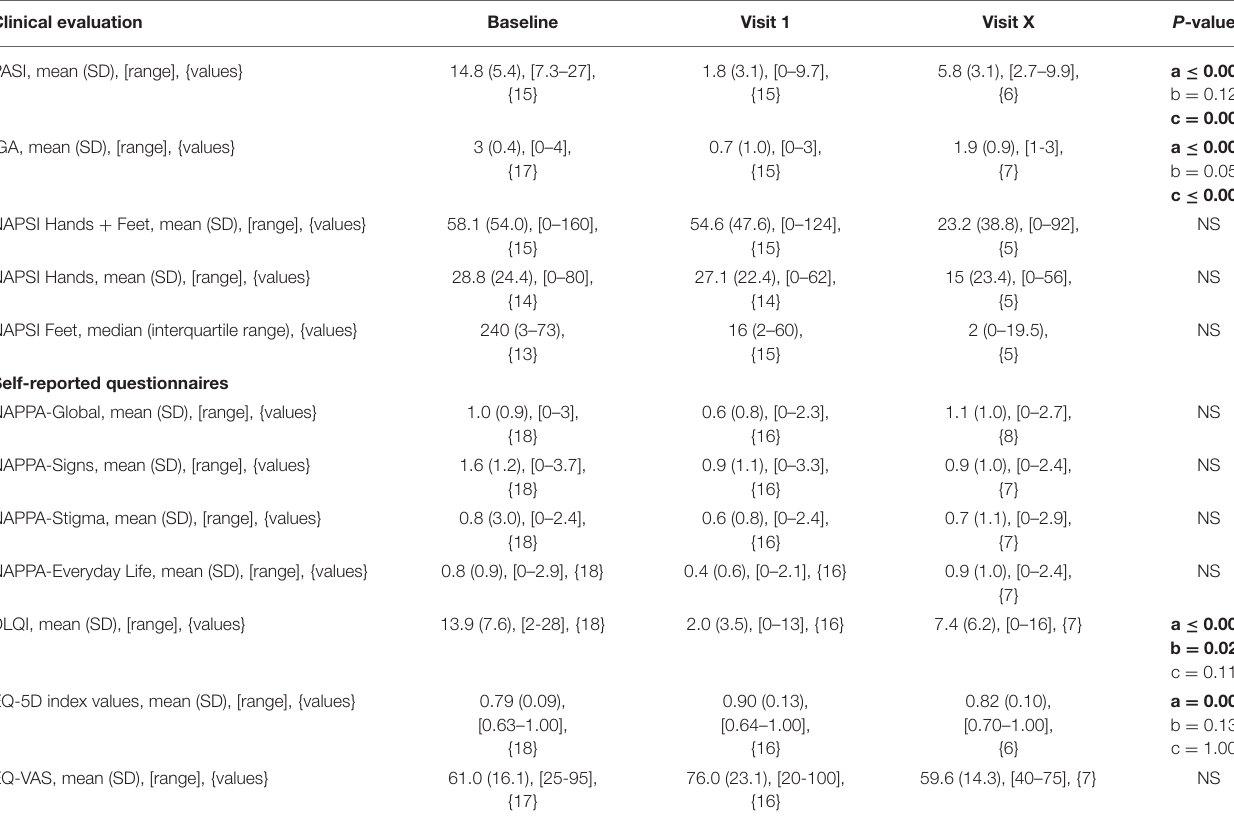
TABLE 2 | Results from clinical and patient questionnaire scores. Clinical evaluation